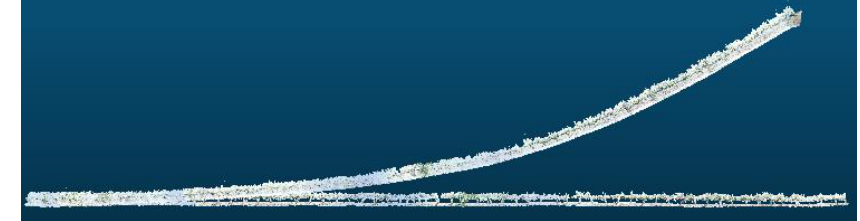
Figure 9. 3D reconstruction of a tree row with drift (up) and the result after the drift correction procedure is applied (down).